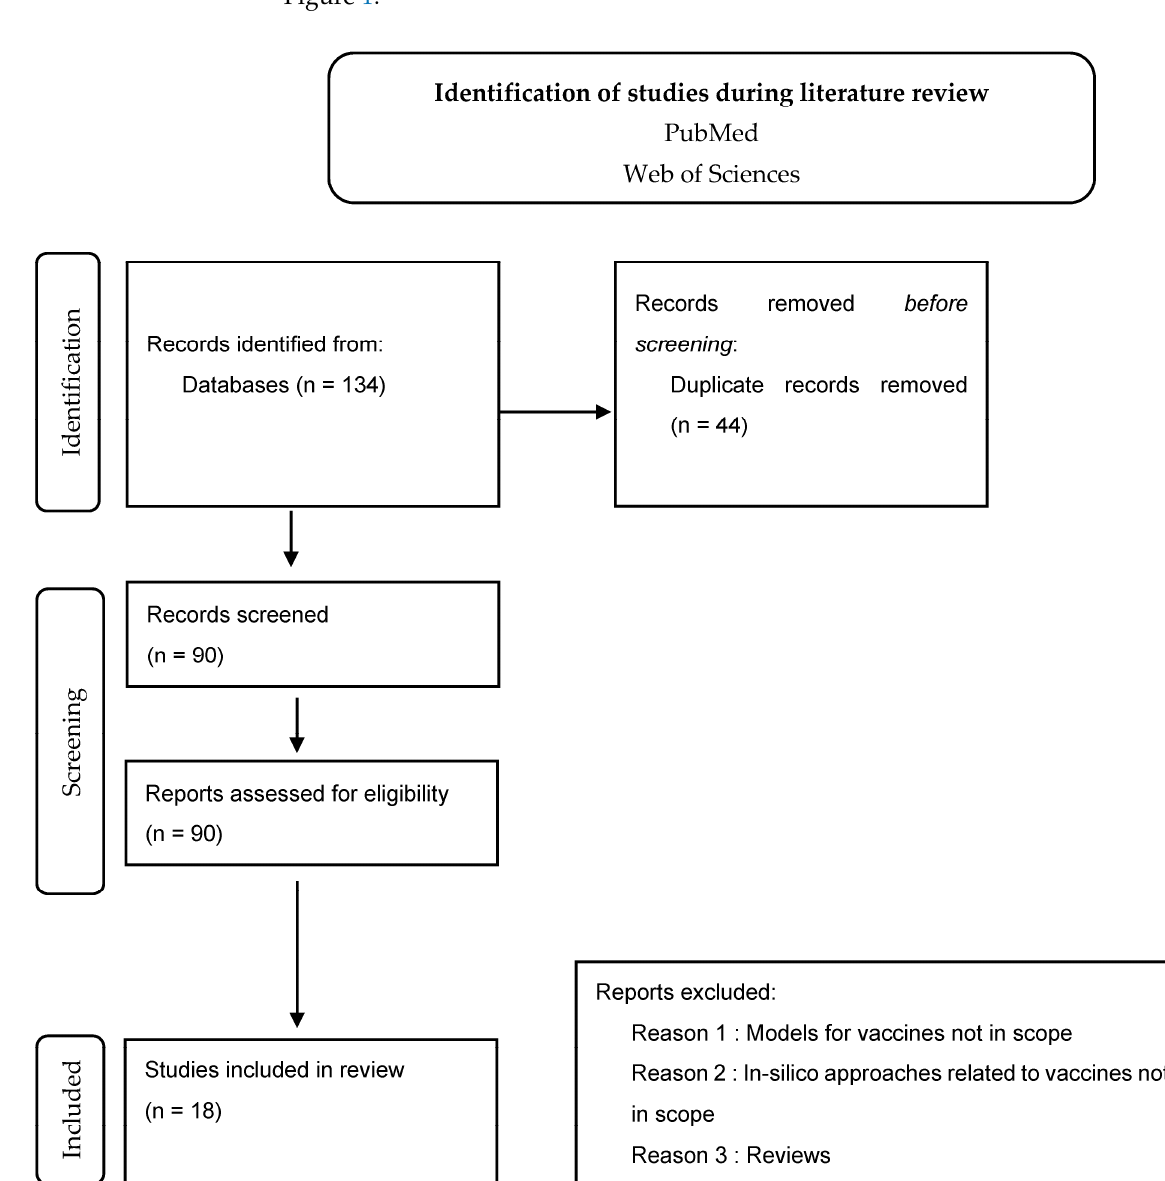
Figure 1. PRISMA flow-chart approach illustrates how the screening was performed.